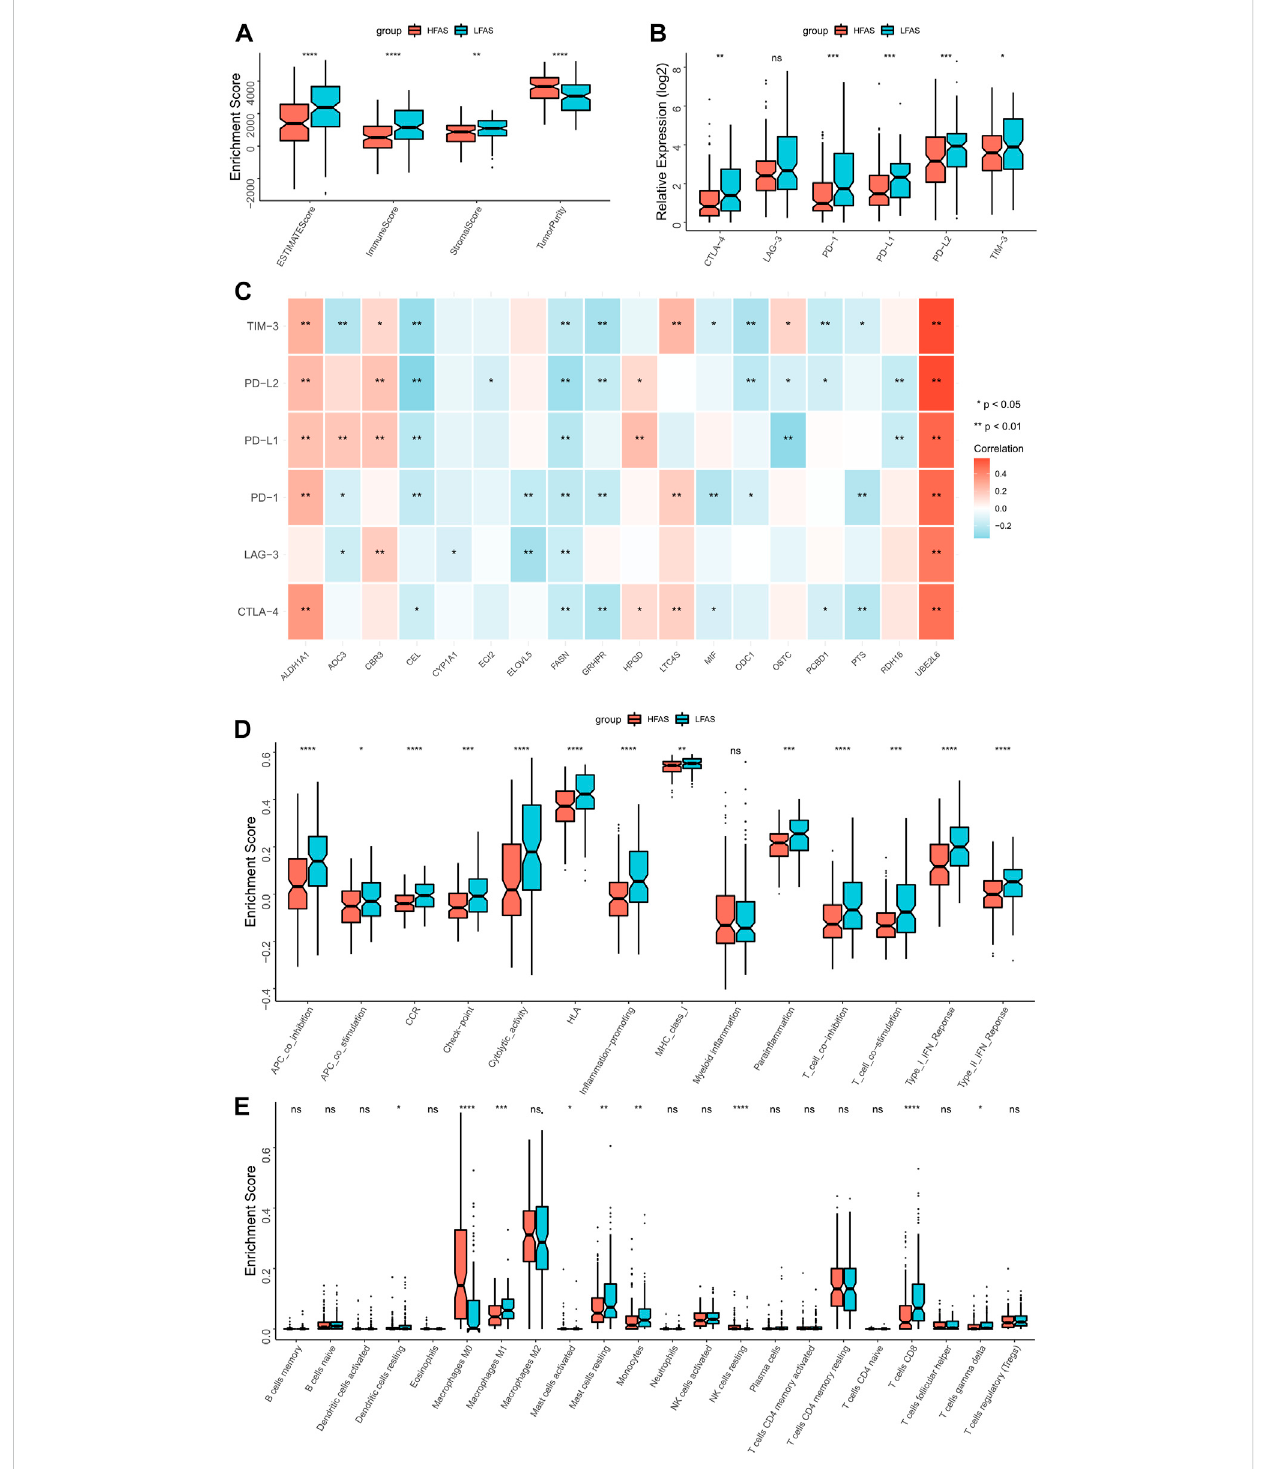
FIGURE 6 The immune landscapes between the high- and low-FAS groups in the TCGA-STS cohort. (A) The immune score between the low- and high-FAS groups. (B) The difference in immune checkpoint expression between the distinct FAS groups. (C) The relationship between the immune checkpoint and theFASgene. (D) Analysisofimmunefunctioninhigh-andlow-FASpatients. (E) Theproportionsof22immune-in fi ltratingcellsbetween thedistinctFAS